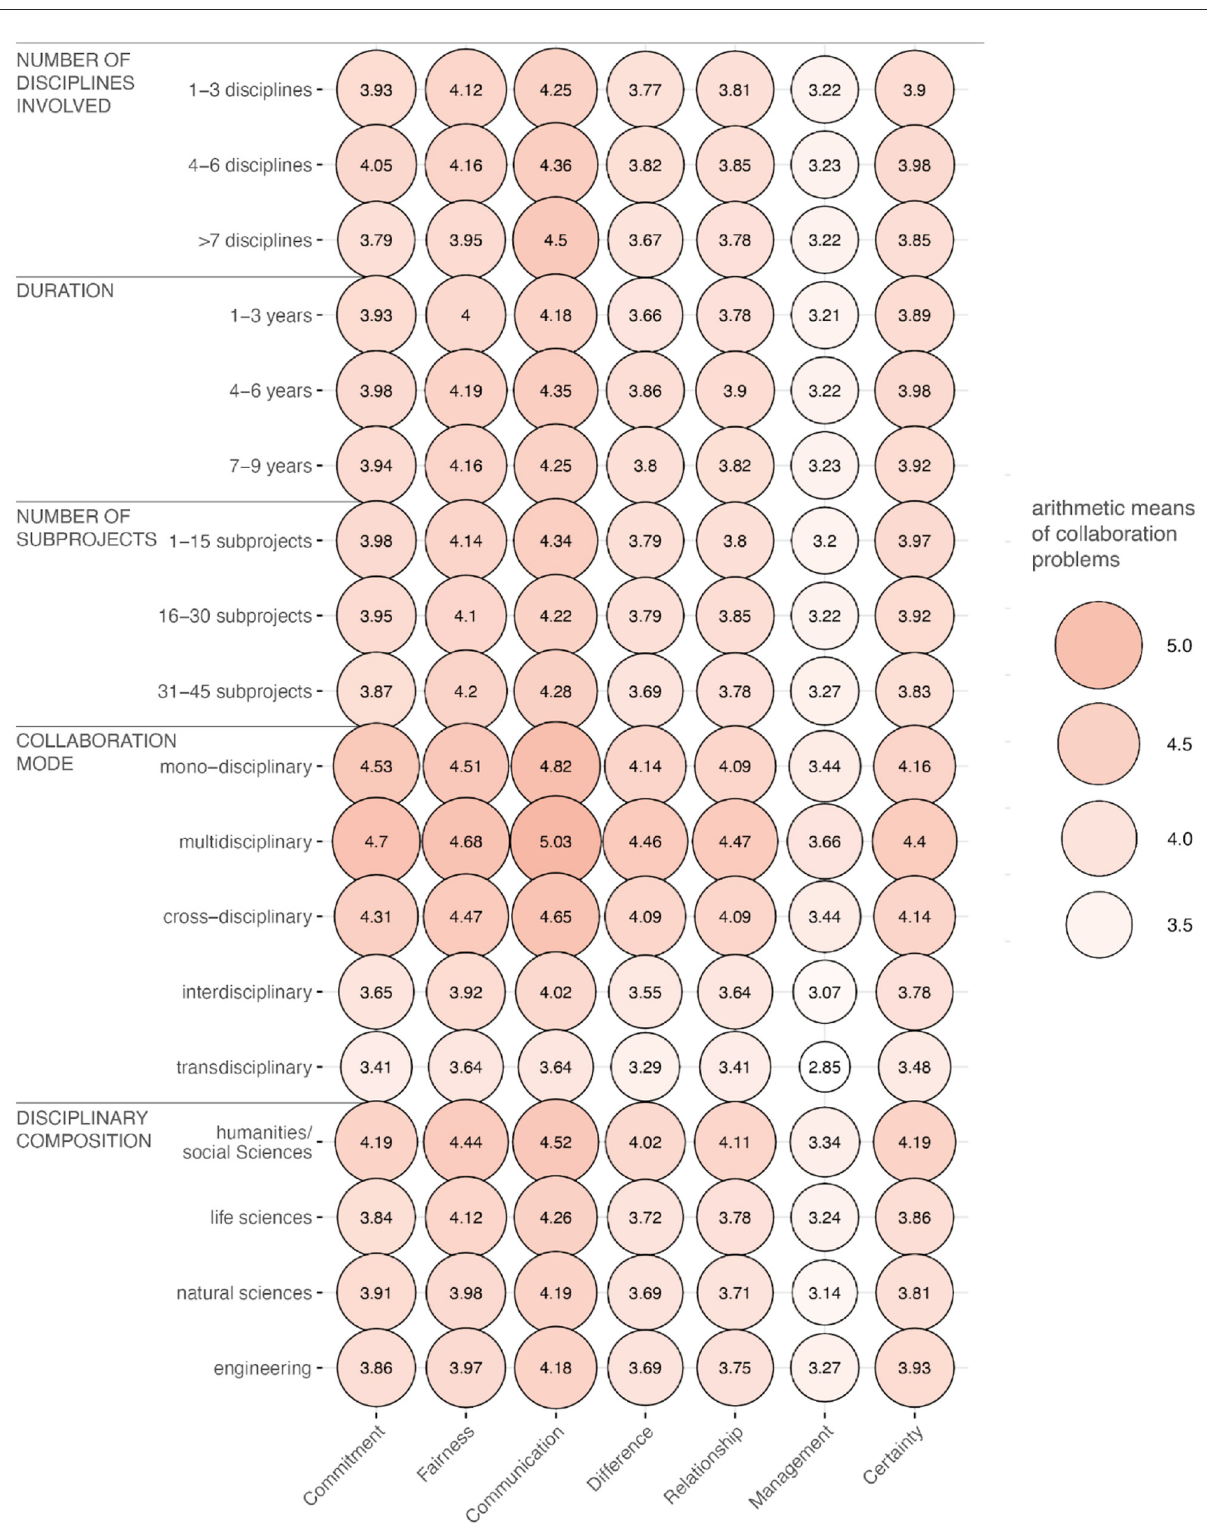
FIGURE2 Perceived relevance of the seven collaboration problems differentiated by RC types. The higher the arithmetic mean values of the cumulative indices, the redder and larger the respective balloon. The graph is based on the survey data of n = 3,050 PIs and spokespersons after listwise